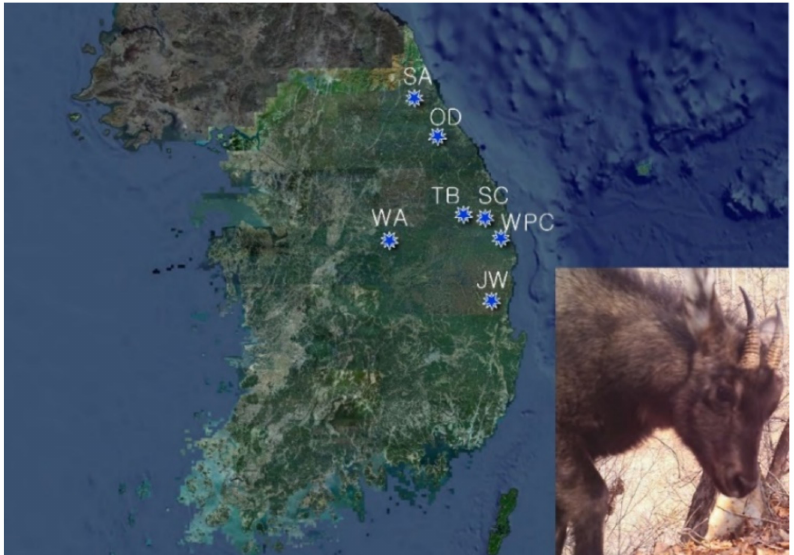
Figure 1. Map of the seven study sites in South Korea, where fecal samples were collected, and photo of the long-tailed goral. Abbreviations: SA = Seoraksan National Park ( n = 24); OD = Odaesan National Park ( n = 8); WA = Woraksan National Park ( n = 6); TB = Taebaeksan National Park ( n = 3); SC = Samcheok Area ( n = 27); WPC = Wangpicheon Conservation Area ( n = 14); JW = Juwangsan National Park ( n = 4). Map generated from QGIS 3.10.12 with VWORLD